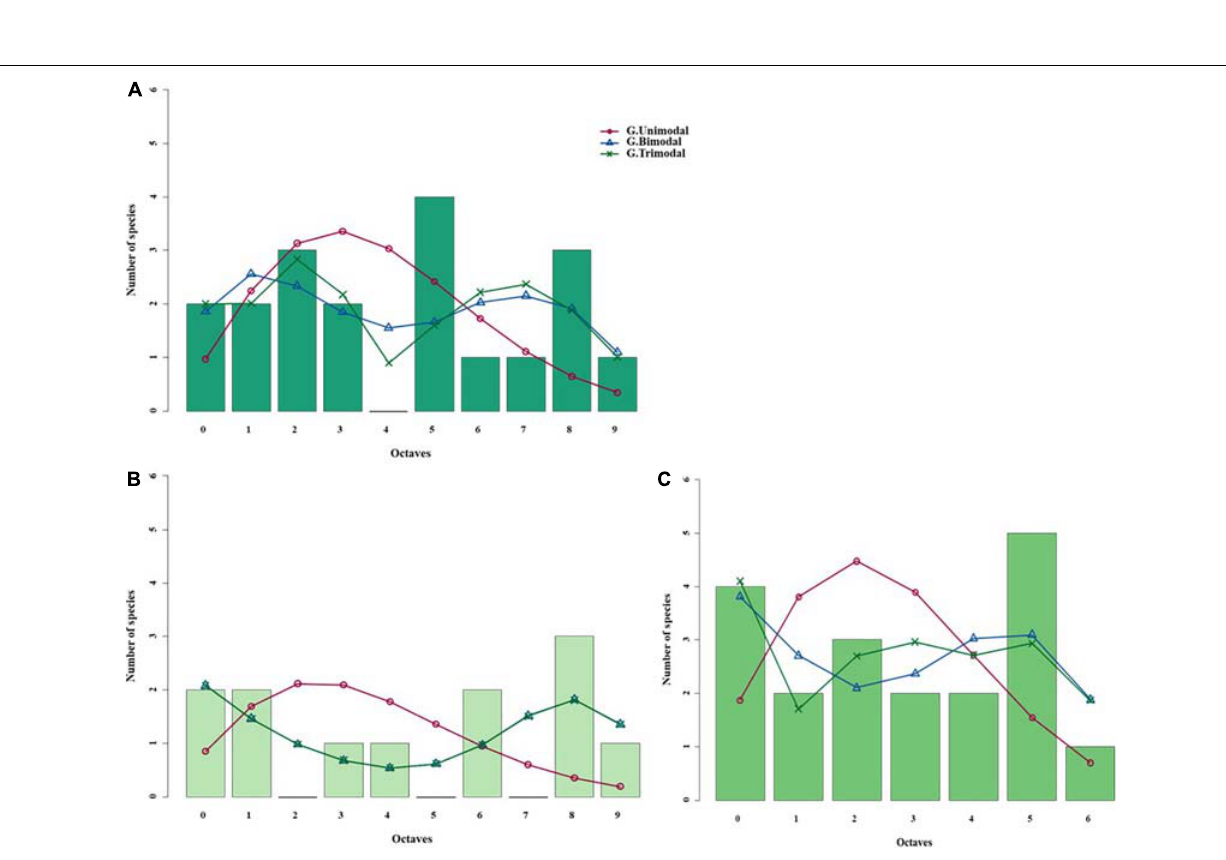
Frontiers in Ecology and Evolution |